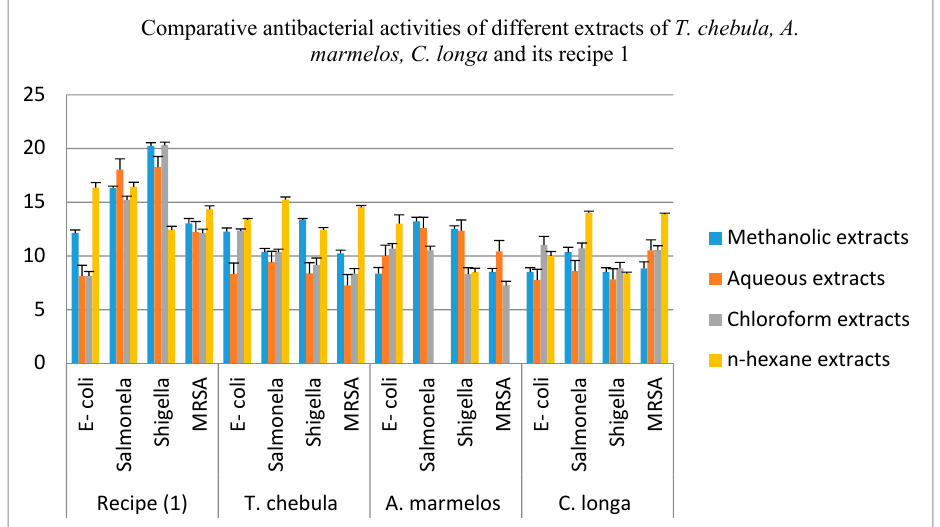
Figure 2. Comparative Antibacterial Activities of methanol, Aqueous, chloroform and n-hexane extracts of the T. chebula (fruits), A. marmelos (fruits), C. longa (rhizomes) and their recipe 1. Each column represents the mean value of three independent replicates and the error bars indicate standard